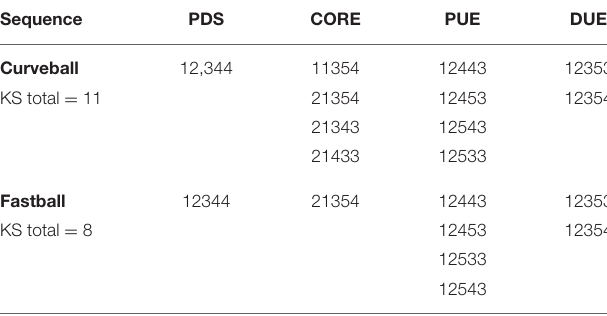
TABLE 3 | List of the Kinematic Sequences within each pitch type within the Kinematic Sequence Category groups. Sequence